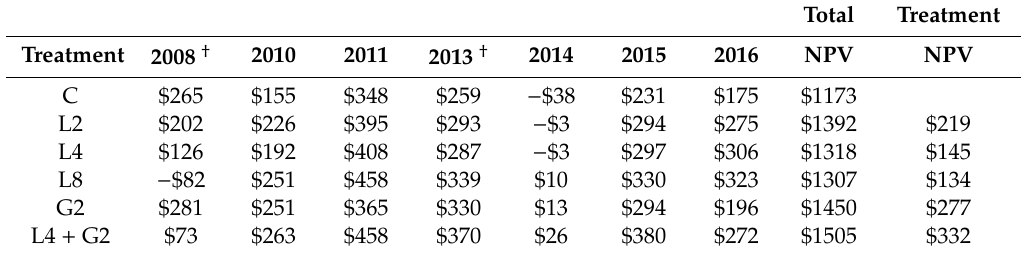
Table 6. Profit ($ ha − 1 ) calculated from the LT experiment, for the 7 sampling years 2008–2016. The total net present value (NPV) was calculated over the study period. Treatment NPV is the total NPV for the treatment minus total NPV of the control. Treatments were applied twice, in March of 2008 and 2013.